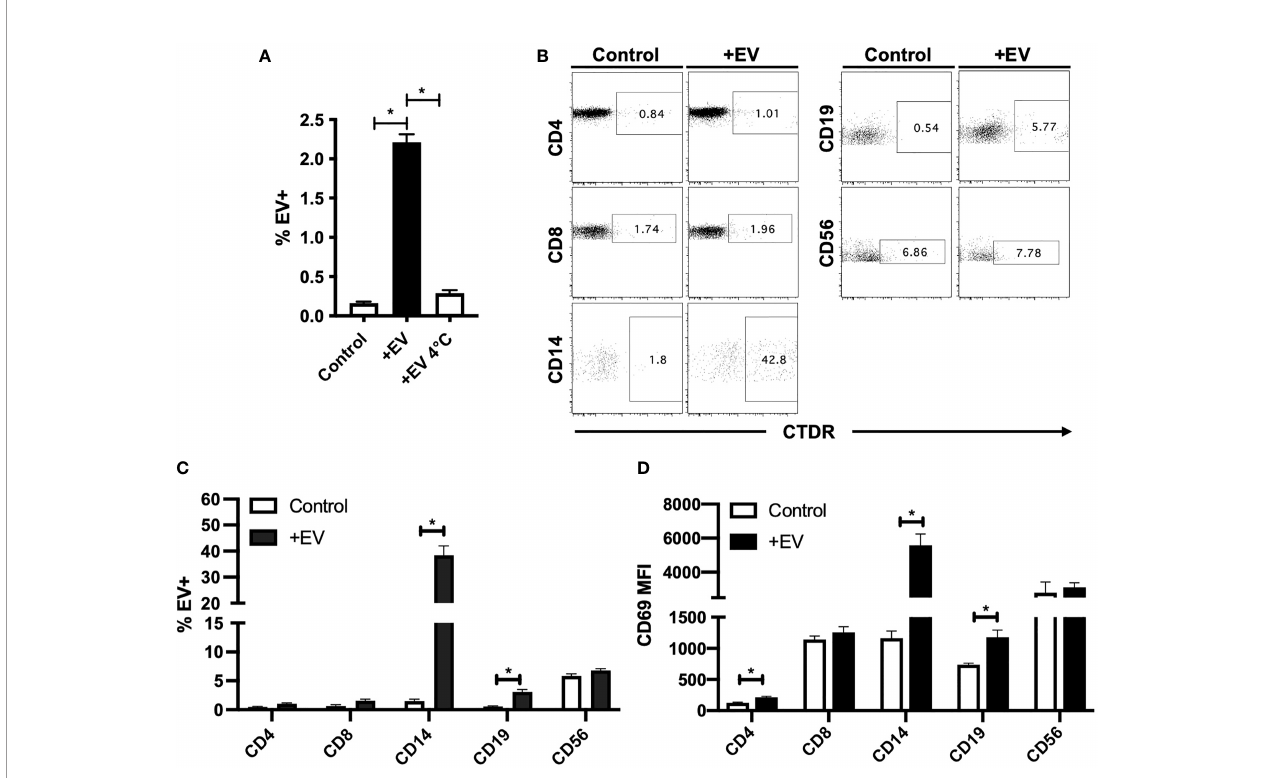
FIGURE 2 | KP-EV interact with PBMC, speci fi cally monocytes and B cells. (A) HC PBMC (n=4) were incubated with CTDR (1 m M) labelled KP-EV for 24 hours at either 4°C or 37°C and KP-EV+ PBMC were measured by fl ow cytometry. (B, C) HC PBMC (n=4) were incubated with CTDR (1 m M) labelled KP-EV (n=4) for 24 hours and KP-EV+ PBMC were measured by fl ow cytometry. As a negative control, KP-EV from KPS-1 were labelled and co-cultured in parallel. Cell surface markers for T cells (CD4 + and CD8 + ), B cells (CD19 + ), monocytes (CD14 + ) and NK Cells (CD56 + ) and KP-EV+ cells were analyzed. Representative dot plots show the percentage of cells that are KP-EV+. (D) CD69 MFI was measured in gated CD4 + , CD8 + , CD14 + , CD19 + and CD56 + cells upon PBMC (n=4) exposure to KP-EV (n=4) for 24 hours. *represents p-values ≤